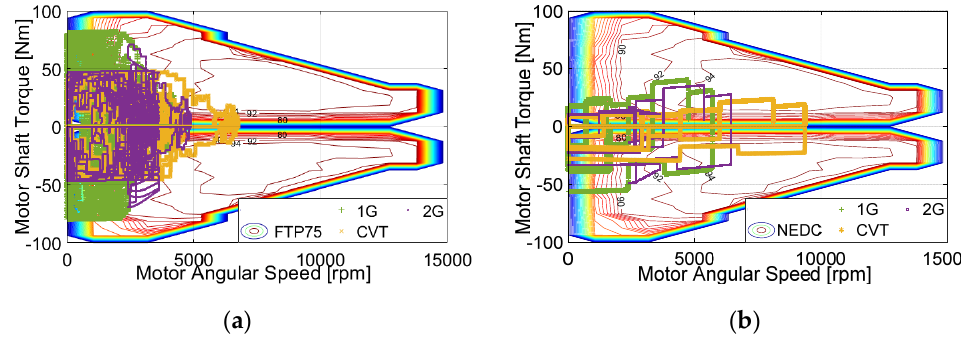
Figure 9. Operation points of the EV equipped with one-stage (1G), two-stage (2G), and CVT transmission for ( a ) the FTP75 and ( b ) NEDC.